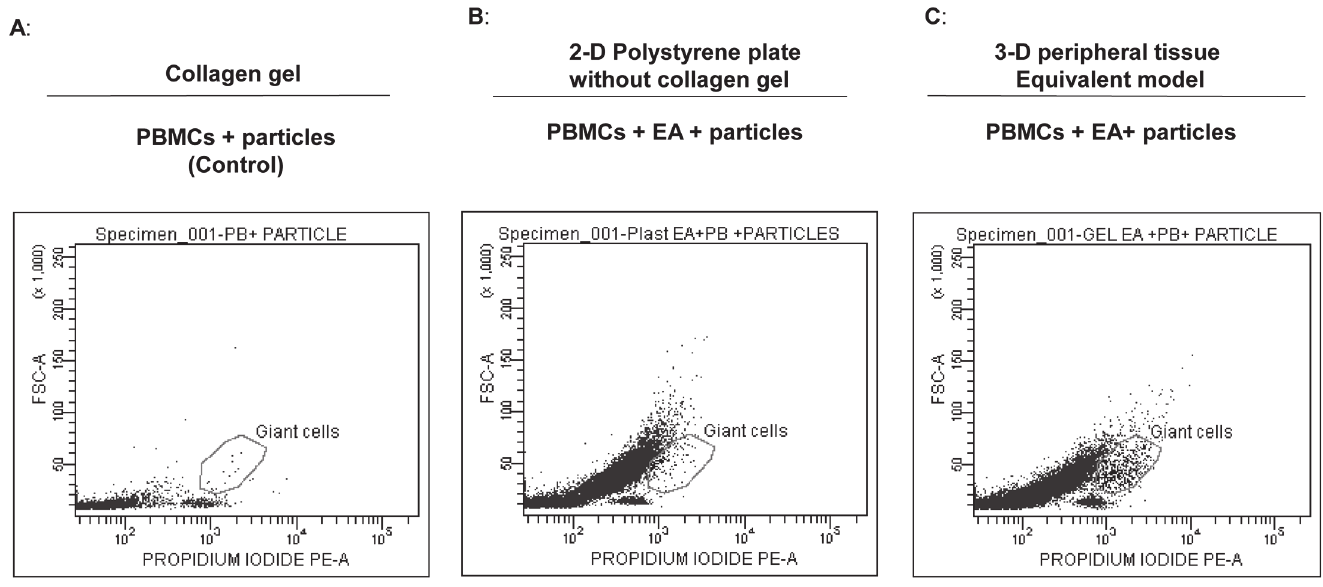
Fig 2. 3-D model containing collagen gel generates a greater number of MGCs. For the 3D model, 100 million particles were added at the time of gel polymerization (a ratio of 100:1 particles: PBMCs) and a monolayer of endothelial cells was grown on top of the gel (C). For the 2D model, endothelial cells were grown to form a monolayer and the particles were added to the monolayer (B). One million PBMCs were seeded on top of the endothelial monolayer in both models and incubated for 2 weeks. As a control, PBMCs alone were exposed to gel embedded with particles (A). On the 14th day, cells were harvested (following collagenase treatment in the 3D model), fixed and permeabilized using BD cytofix/perm buffer. Cells were then stained with PI and acquired on a flow cytometer.